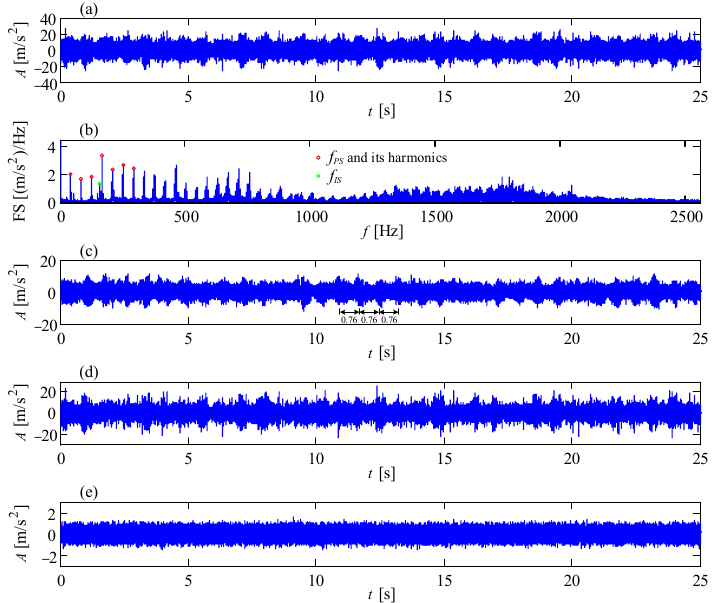
Figure 24. Demodulation results by resonance-based sparse decomposition: ( a ) vibration signal from faulty planetary subassemblies; ( b ) Fourier spectrum; ( c ) high Q component; ( d ) low Q component; ( e ) noise component.